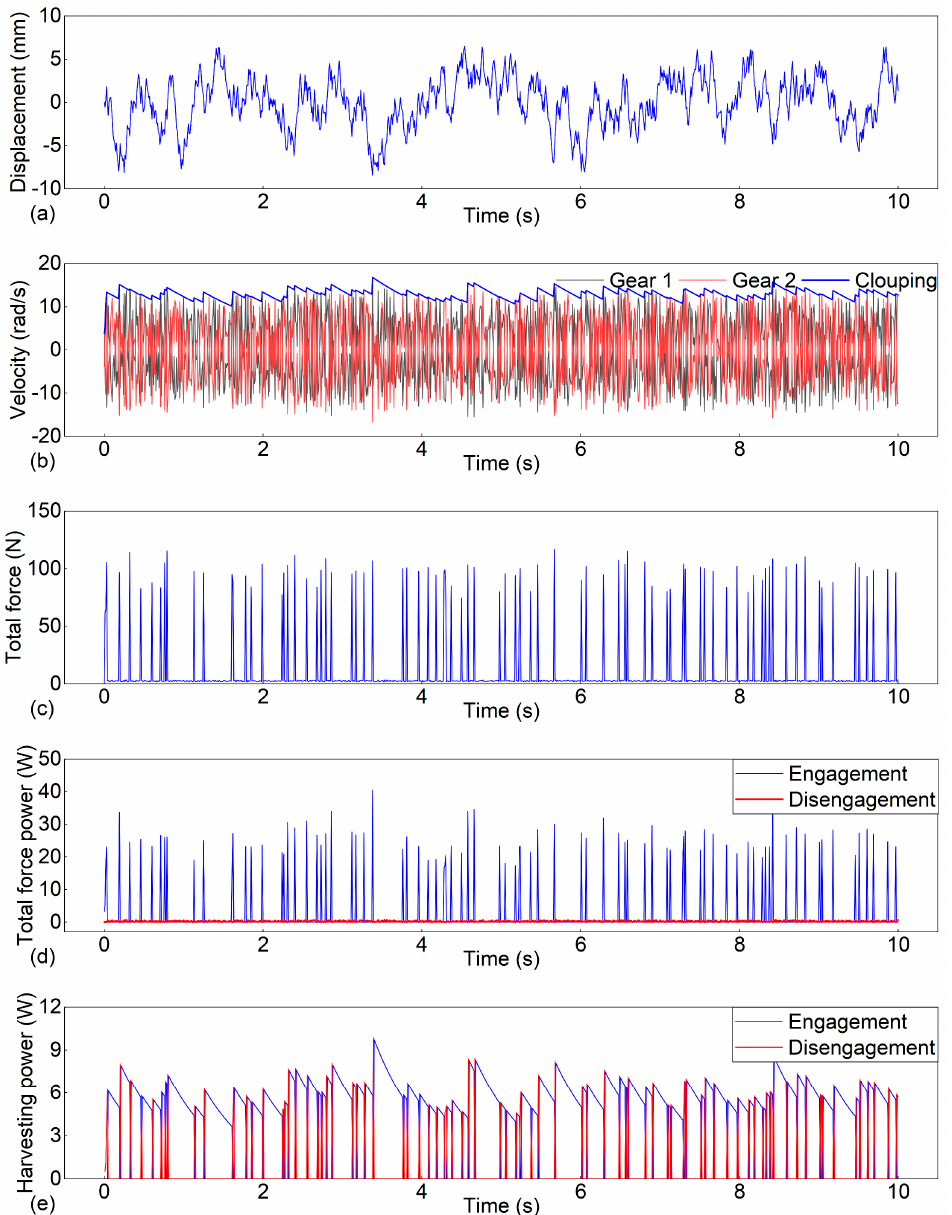
Figure 14. The operating characteristics of an MMR − EHSA subjected to random vibrations. ( a ) Input displacement. ( b ) Velocity characterization. ( c ) Total force. ( d ) Total force power. ( e ) Harvesting power.